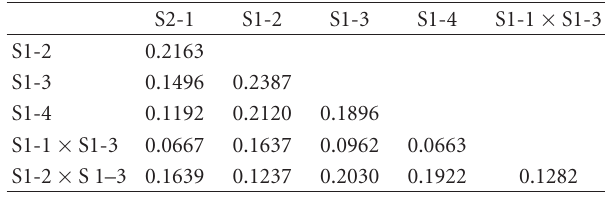
Table 3: F st values estimated by FSTAT program [13] between L. vannamei shrimp stocks used for culture in Cuba. For all comparisons, P value = 0.00067; it was obtained after 1500 permutations also by the FSTAT program. Indicative adjusted nominal level (5%) for multiple comparisons is